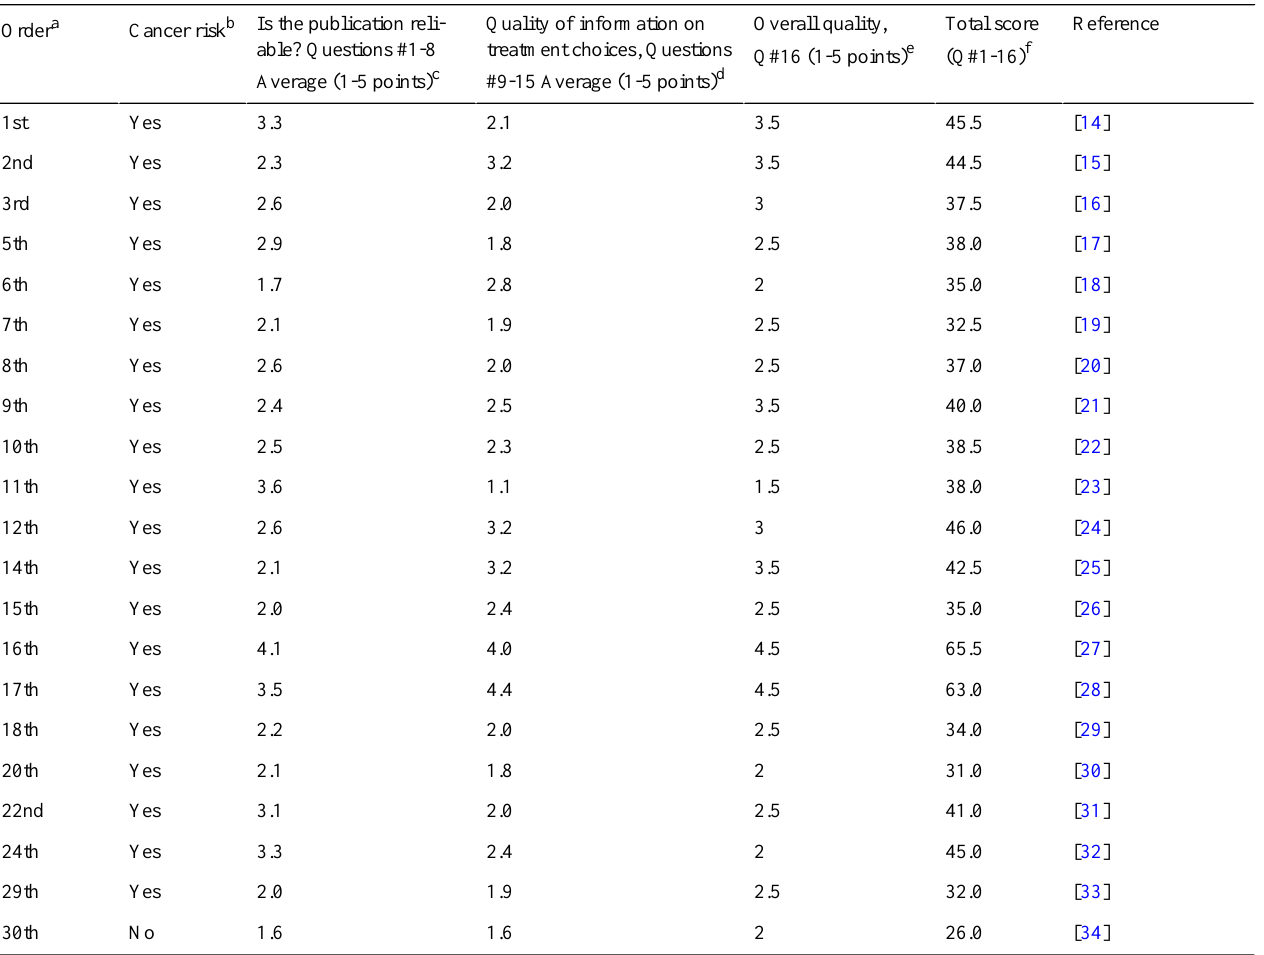
Table 2. Quality scores for the websites describing pancreatic cysts (DISCERN questionnaire, 1-5 points for each